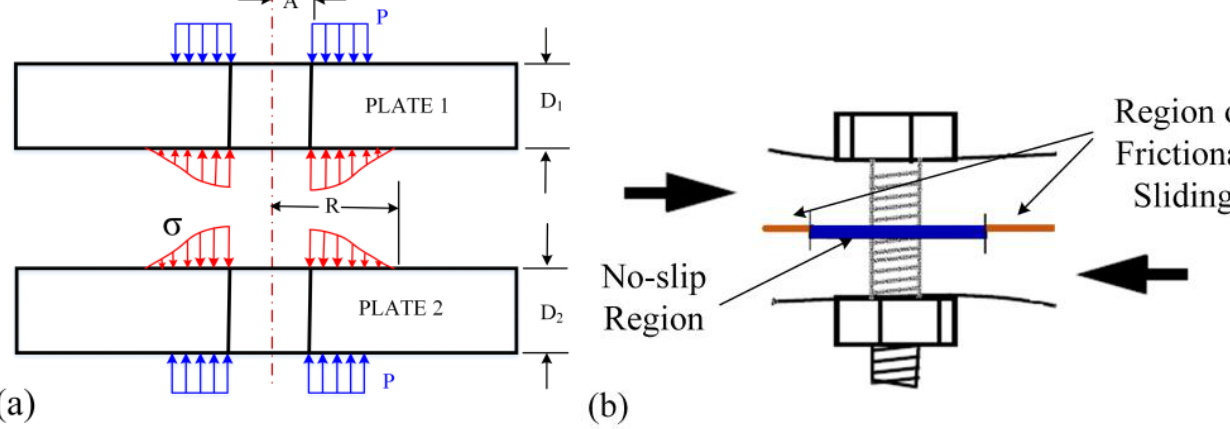
Figure 2. Illustration of a bolted joint, ( a ) Qualitative representation of the pressure distribution [9], ( b ) Sliding in the contact patch [11].